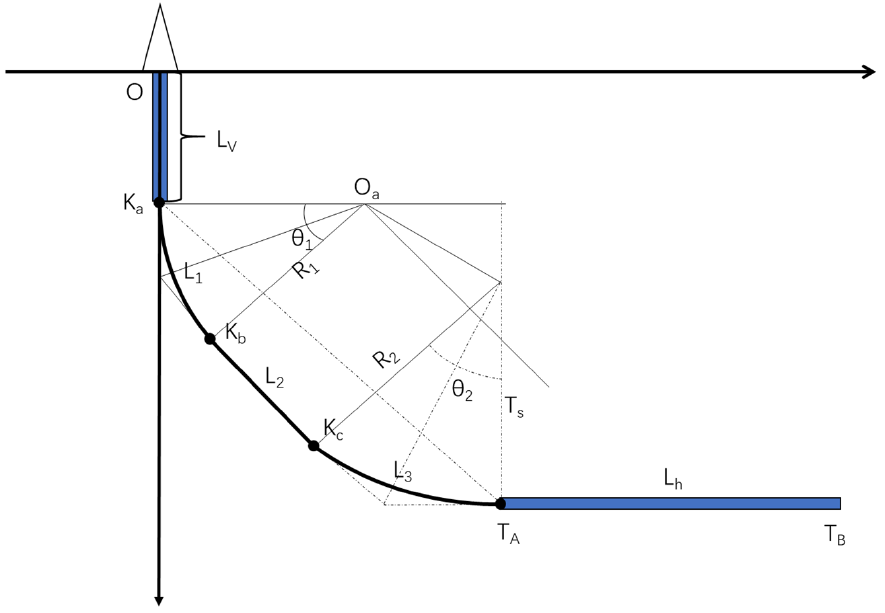
Figure 1. Drilling section design (projection of the plumb plane).